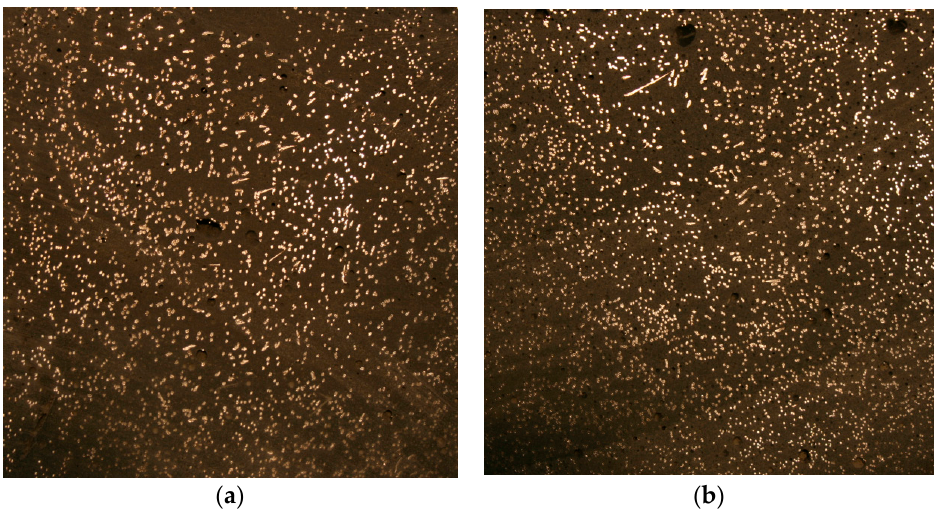
Figure 10. Images of fiber distribution for Mix 2 ( a ) at 35 mm away and ( b ) at 220 mm away.